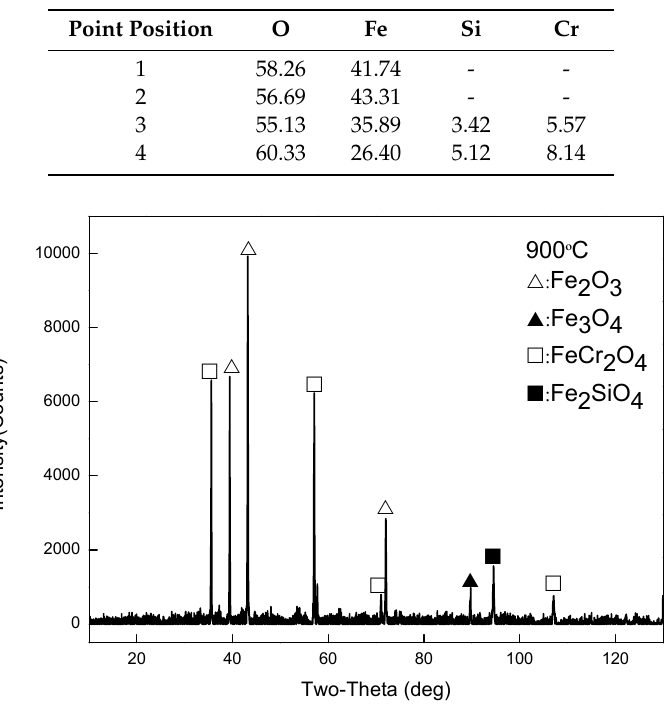
Figure 7. XRD data for the oxide scales obtained at 900 °C.